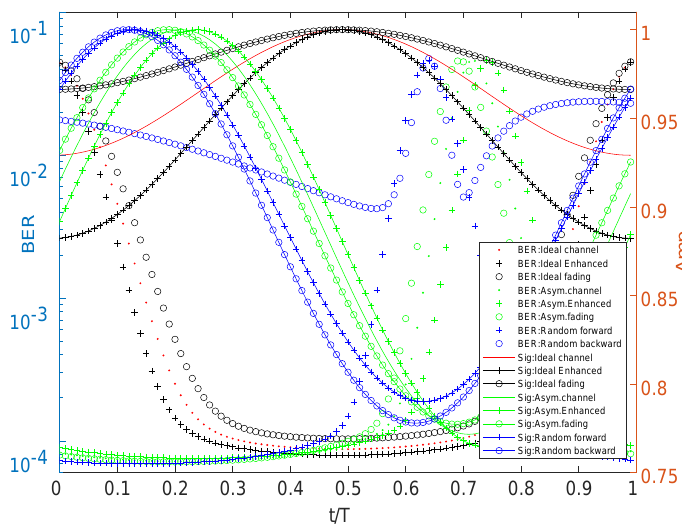
Figure 3. Signal and BER for ideal channel.